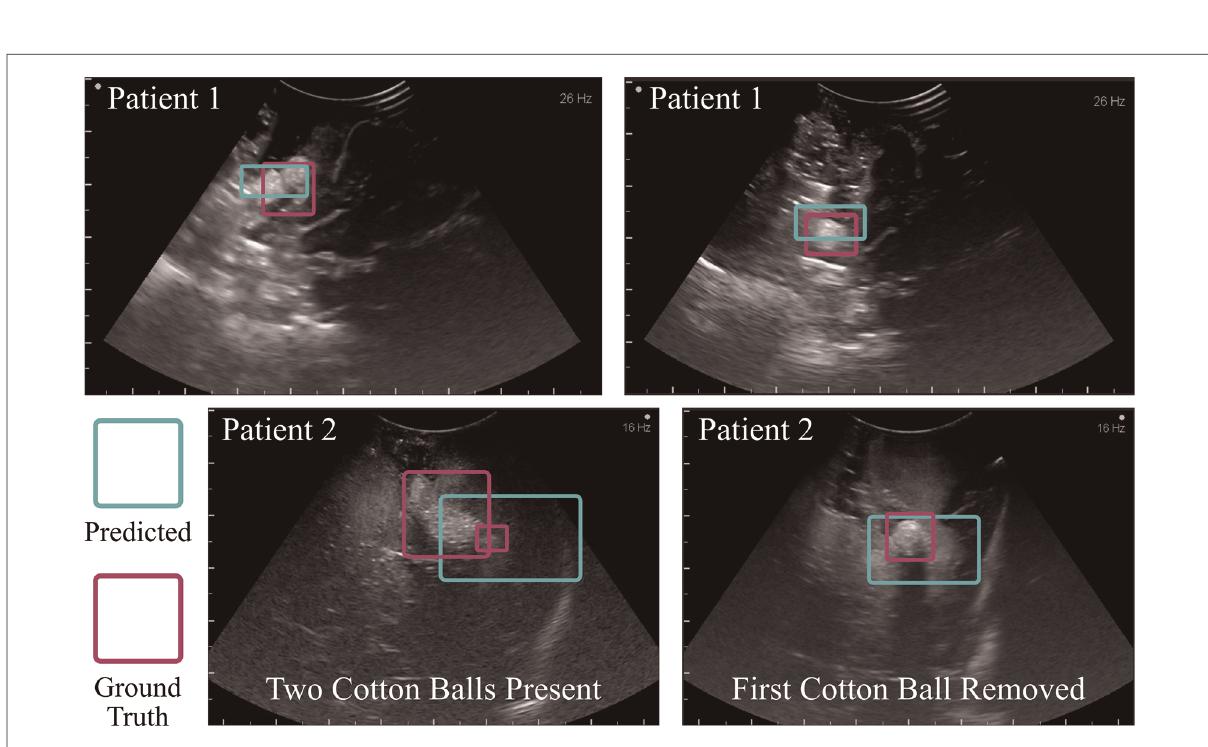
FIGURE 10 Algorithmic implementation in humans. The trained model, without any changes beyond initial contrast enhancement of the images, was used to detect cotton balls in a human brain following neurosurgery. The top two example images were taken towards the end of an aneurysm surgery. The bottom two images were captured following a tumor resection procedure. One cotton ball was known to be placed within the cavity (left), and upon removal of this object a second cotton ball was found (right). This study prevented accidental retention of an unidenti fi ed foreign body object. Intentionally placed cotton balls had a diameter of 10mm prior to placement within the cavity, which alters the shape. The initially unseen cotton ball in Patient 2 was 5mm in diameter.